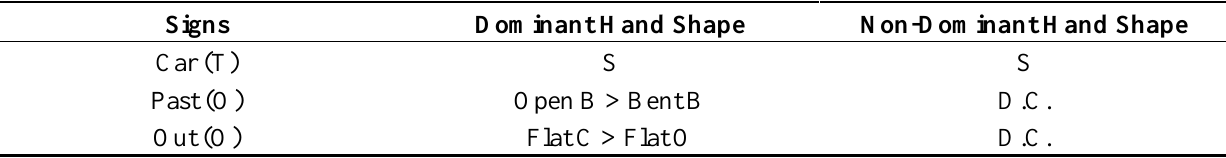
Table 2. Examples of hand shapes for sign language recognition: Categories of hand shapes are described in [1,3].